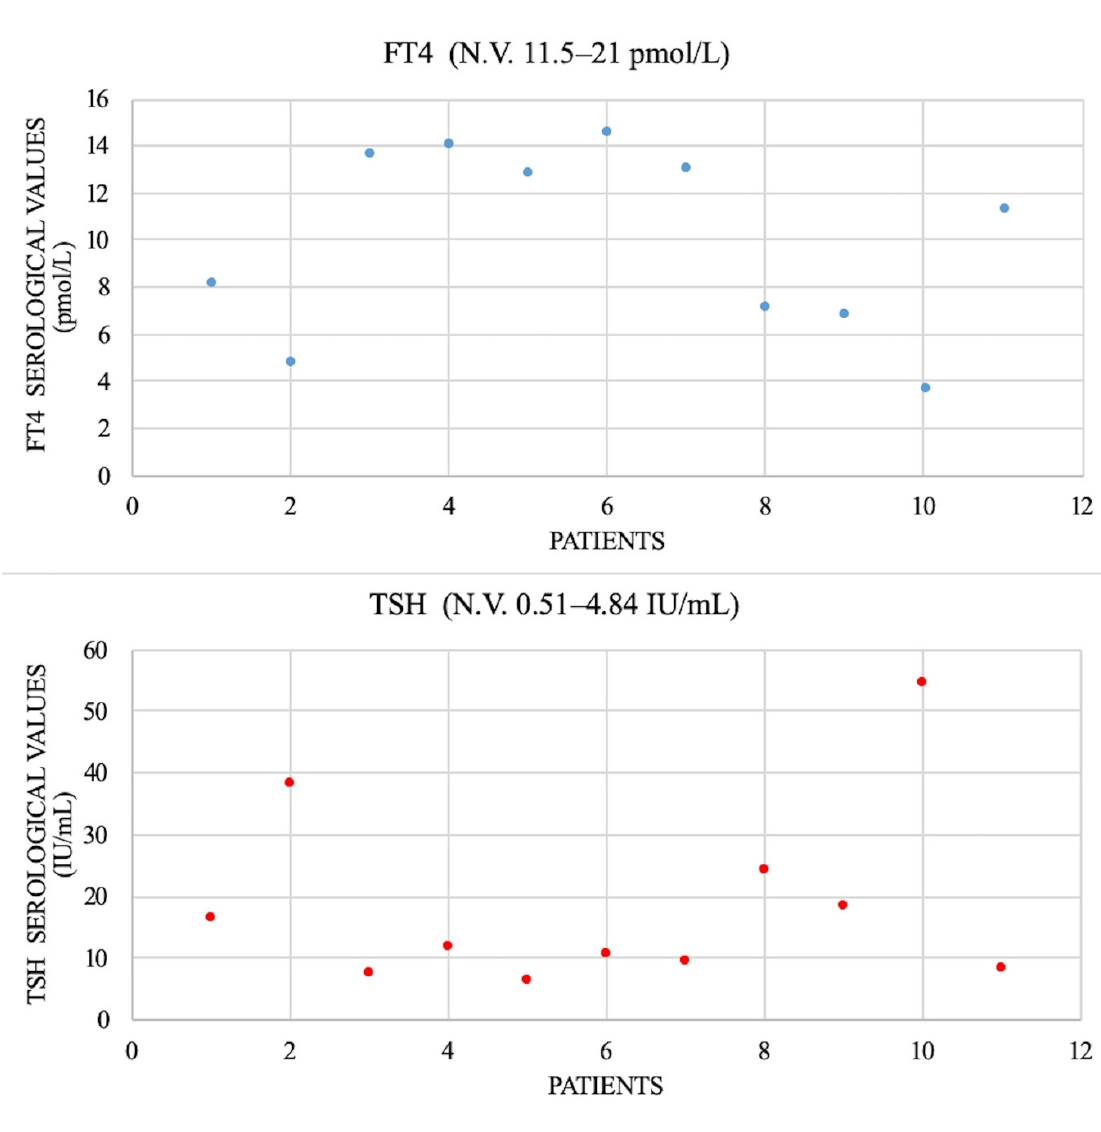
Figure 3. Serological levels of thyroid-stimulating hormone (TSH – red dots) and free thyroxine (FT4 – blue dots) of the patients who developed dysfunction after brain tumor treatment.